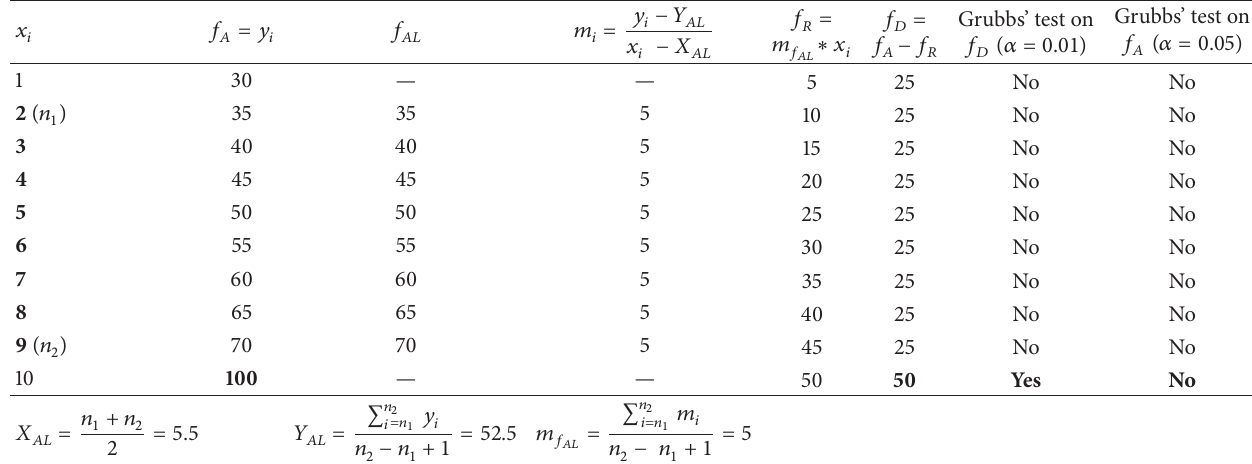
Figure 6: Outlier detection of volumetric percentage of CH4 in biogas with new transformation technique for significance level of 0.05 for different window sizes without overlap. Plots (a), (b), (c), and (d) correspond to window sizes 4, 5, 6, and 10, respectively. Table 3: Data set 1 ( 𝑛 = 10 ): last element is the outlier and deviates considerably. With new transformation technique, Grubbs’ test on 𝑓 𝐷 is capable of identifying the outlier with significance level of 0.01. However, Grubbs’ test on 𝑓 𝐴 is capable of identifying the outlier with even significance level of